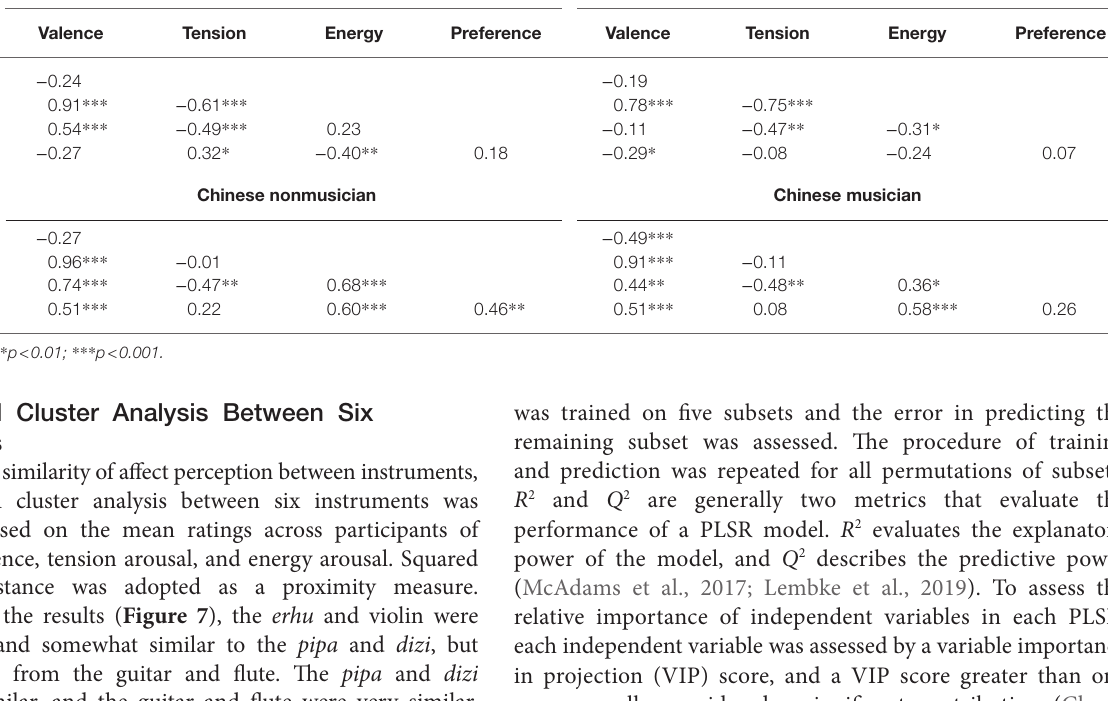
TABLE 3 | Pearson’s correlation coefficients of ratings of perceived valence, tension arousal, energy arousal, preference, and familiarity. Western nonmusician Western musician Valence Tension Energy Preference Valence Tension Energy Preference Tension